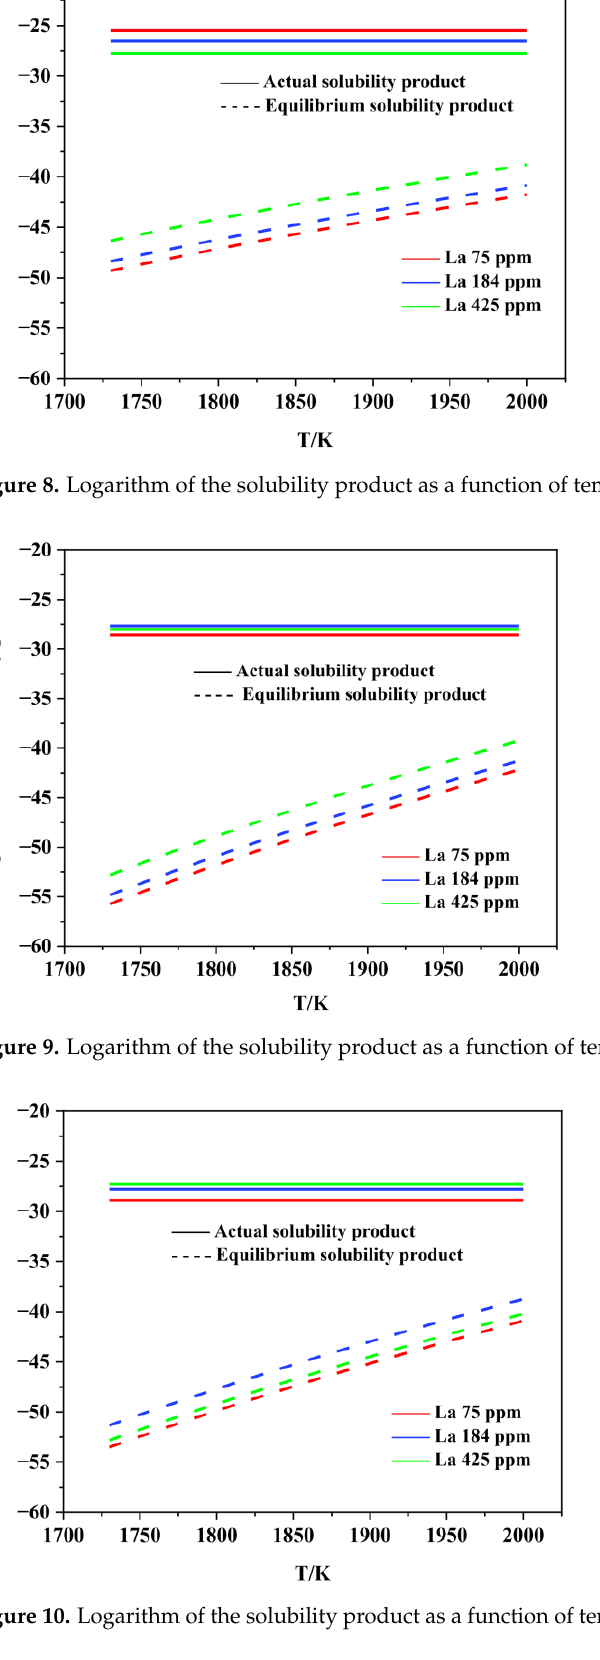
Figure 11. Logarithm of the solubility product as a function of temperature for La 2 S 3 in liquid steel.